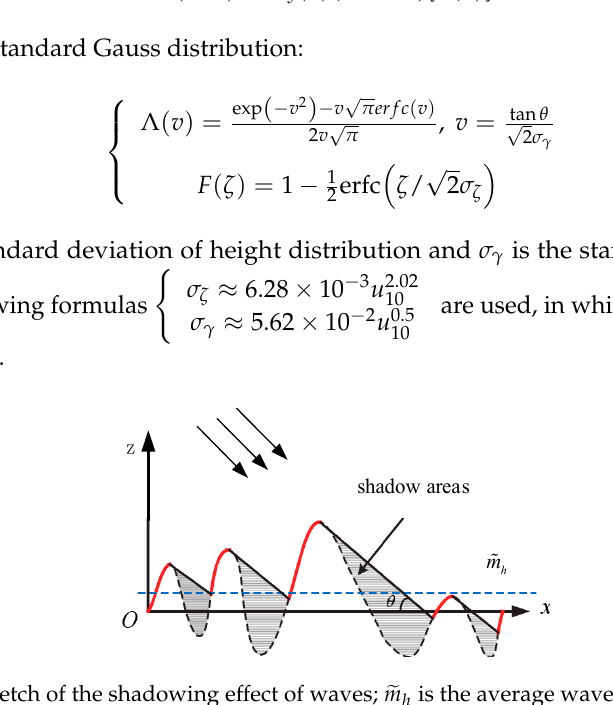
Figure 3. The sketch of the shadowing effect of waves; 𝑚(cid:3557) (cid:3035) is the average wave height. Because of the shadow effect, electromagnetic waves can only illuminate a part of the sea surface, and the roughness attenuation factor is different from Miller-Brown method.